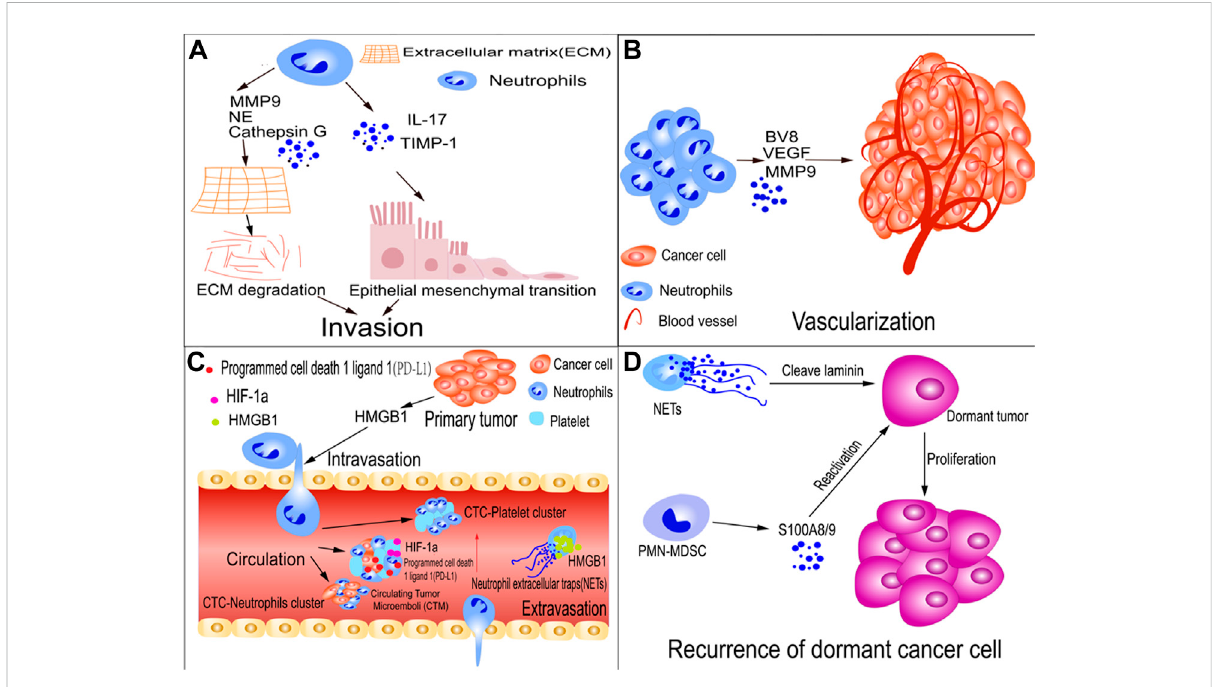
FIGURE 2 TANrolesintumormetastasis. (A) TANspromotetumor-cellinvasion;neutrophil-secretedTIMP-1orIL-17promotemetastasisbyinducingthe epithelial-mesenchymaltransition(EMT).Similarly,TANscausecancercellstoundergoEMTbyactivatingJAK2/STAT3signaling.TANssecretematrix metalloproteinase-9 (MMP-9), cathepsin G, and neutrophil elastase (NE), which degrade the extra-cellular matrix (ECM), thereby allowing tumors to invade adjacent tissues. (B) TANs promote tumor cell vascularization; neutrophils encourage tumor metastasis by releasing proteins such as MMP-9, vascular endothelial growth factor (VEGF), and BV8, which promote tumor angiogenesis. (C) TANs facilitate intravasation and extravasation of tumor cells and the survival of circulating tumor cells (CTCs); HMGB1 is released by tumor cells to recruit neutrophils, which assist tumor cells in invading blood vessels. CTC, CTC-neutrophil, and CTC-platelet clusters shield tumor cells from shear stress and natural killer (NK) cell assault. Hypoxia-induciblefactor-1 α (HIF-1 α )expressionisincreasedincirculatingtumormicroemboli(CTM)inthelungs. (D) Recurrenceofdormantcancer cells; NETs cleave laminin, which results in the generation of an epitope. When a dormant cancer cell recognizes the epitope, signaling encourages tumor cells to awaken and proliferate. Polymorphonuclear myeloid-derived suppressor cells (PMN-MDSCs) awaken dormant tumor cells by